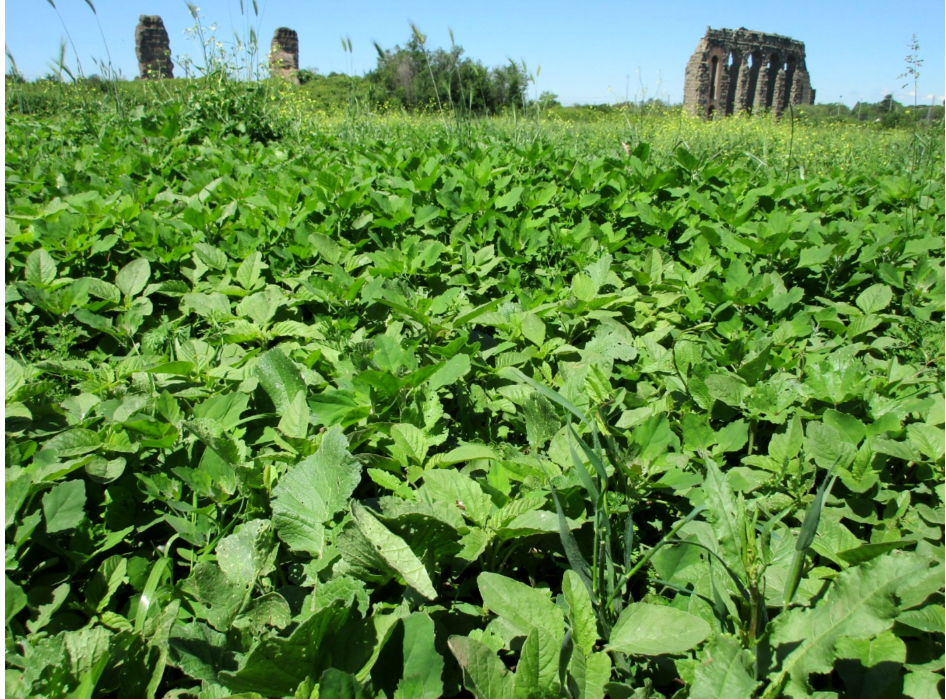
Figure 87. Dense population of young individuals of Amaranthus sp. pl. on a crop (Acquedotti